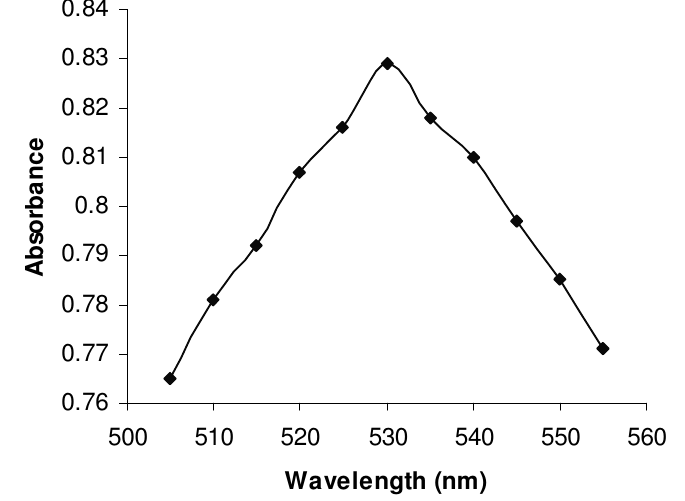
Figure 3. Absorption spectrum of reaction product between alfuzosin (Final concentration 50 µ g/mL) and ascorbic